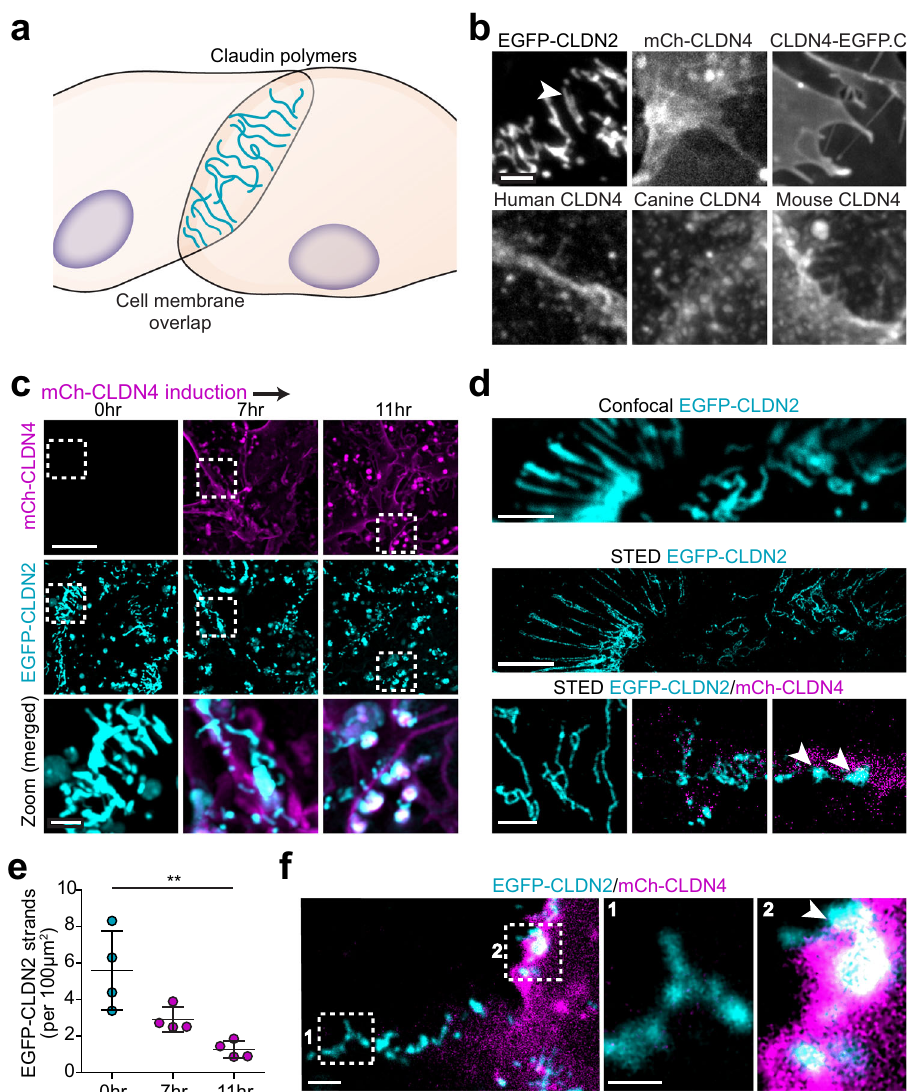
Fig. 5 Claudin-4 fails to assemble into polymeric strands but disrupts those formed by claudin-2. a Claudin proteins expressed in nonepithelial cells form polymers similar to those within epithelial tight junction strands. b EGFP-claudin-2 expressed in U2OS human osteosarcoma cells forms strands (arrowhead). In contrast, mCherry-claudin-4 (human), claudin-4-EGFP (CLDN4-EGFP.C), untagged human claudin-4, canine claudin-4, and mouse claudin-4 all fail to form strands despite being traf fi cked to plasma membranes. Maximum projection images are representative of 3 independent experiments. Scale: 2 μ m. c Live imaging at intervals after induction of mCherry-claudin-4 (magenta) expression shows progressive disruption of EGFP-claudin-2 (cyan) strands. Maximum projection images representative of 5 independent experiments. Scale: 10 μ m; 2 μ m. d Confocal and corresponding STED image of EGFP-claudin-2 polymers (cyan) without claudin-4 expression. STED shows collapse of EGFP-claudin-2 (cyan) polymers into dense aggregates (arrowhead) following mCherry-claudin- 4 (magenta) expression (bottom). Representative of at least 7 independent experiments. Scale: 1 µ m. e Quantitative morphometry shows progressive loss